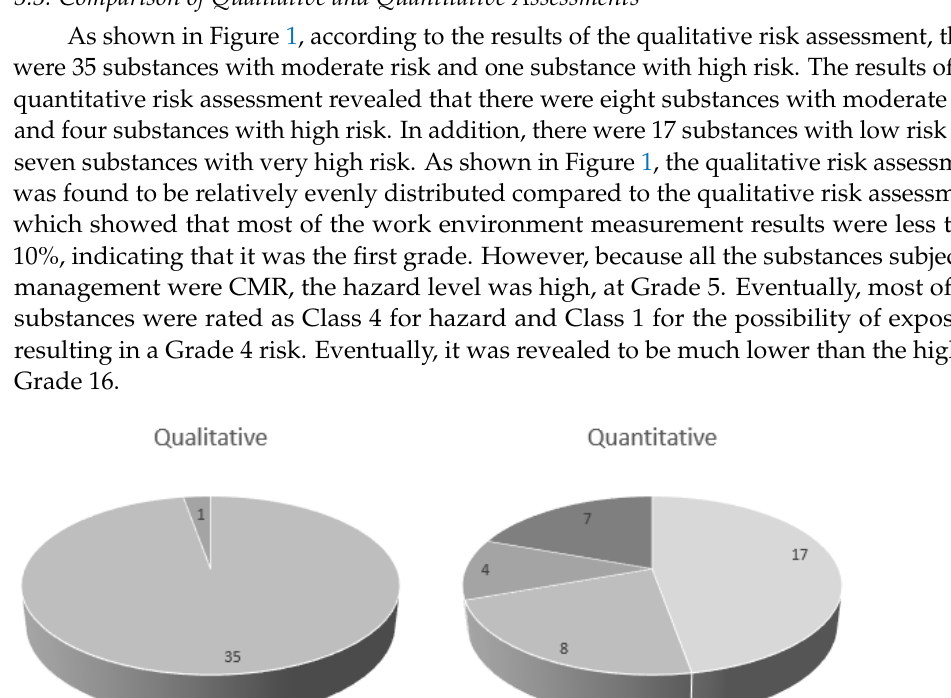
Table 6. Results of the quantitative risk assessment of hazardous substances requiring management. Grades of Risk Substances (No.) CTE * RME ** 12~16 6 7 >1 × 10 0 5~11